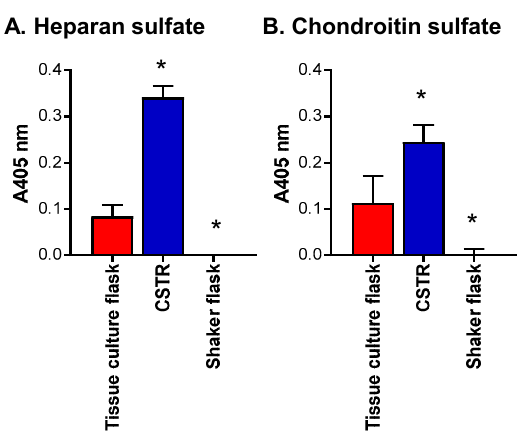
Figure 5. Effect of bioreactors on heparan and chondroitin sulfate structure. ELISA for the presence of ( A ) heparan sulfate chains detected using anti-heparan sulfate chain antibody clone 10E4 and ( B ) chondroitin sulfate chains detected using anti-chondroitin sulfate chain antibody clone CS-56. Data are presented as means ± standard deviation ( n = 3). * indicates significant differences ( p < 0.05) compared to batch cultures analyzed by one-way ANOVA.